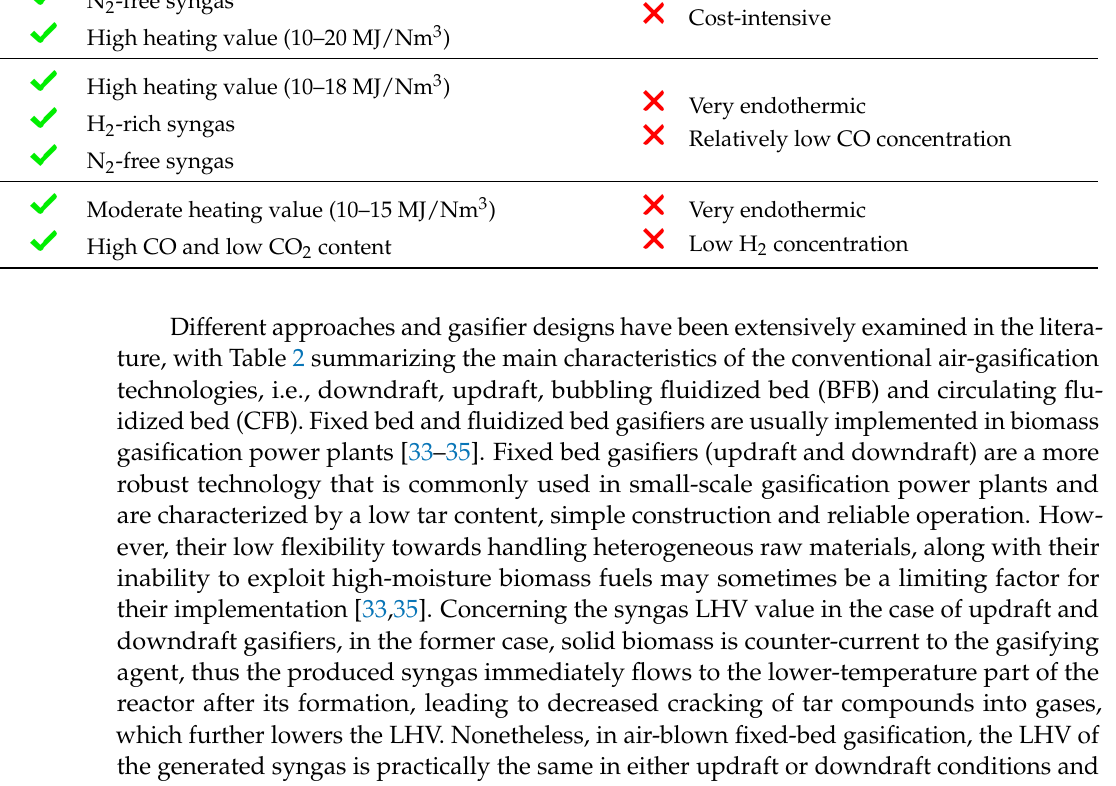
Table 1. Advantages and disadvantages of various gasification agents [31,32].